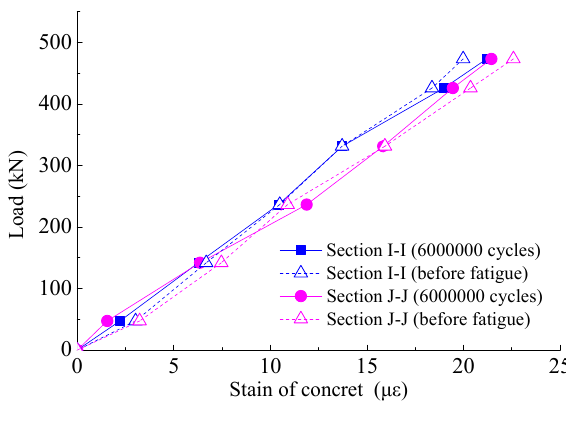
Figure 18. Load-shear strain curves.